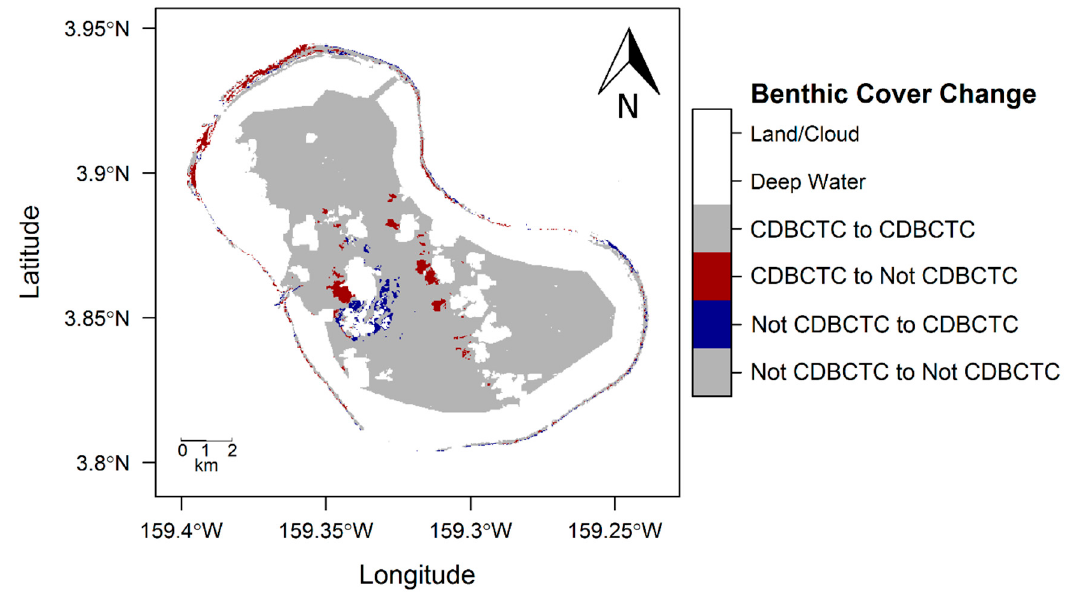
Figure 14. Difference in predicted class membership map for the Tabuaeran Island area of interest for 2000 initial state compared to 2014 final state.